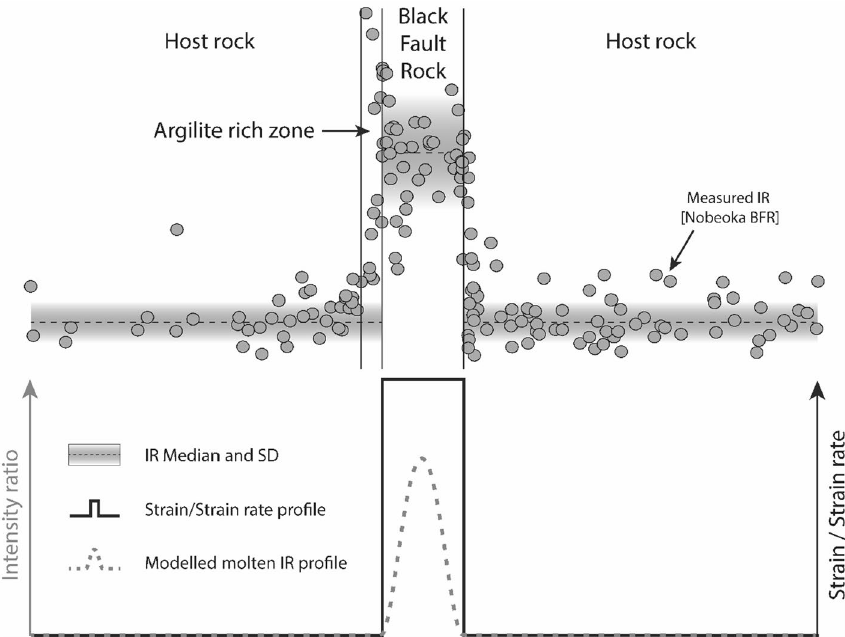
Figure 7. Intensity ratio profile and the amount of strain or strain rate across the host-rock and the Black Fault Rock for the Nobeoka case (with median and standard deviation shown as black dotted lines). Intensity ratio derived from thermal models of a viscously sheared molten layer (case (3)) is superimposed as a grey dotted line. A hypothetical strain/strain rate profile is shown as a black bold line. The stepwise shape of natural profile matches strain/strain rate profile, while it stands at variance with thermal